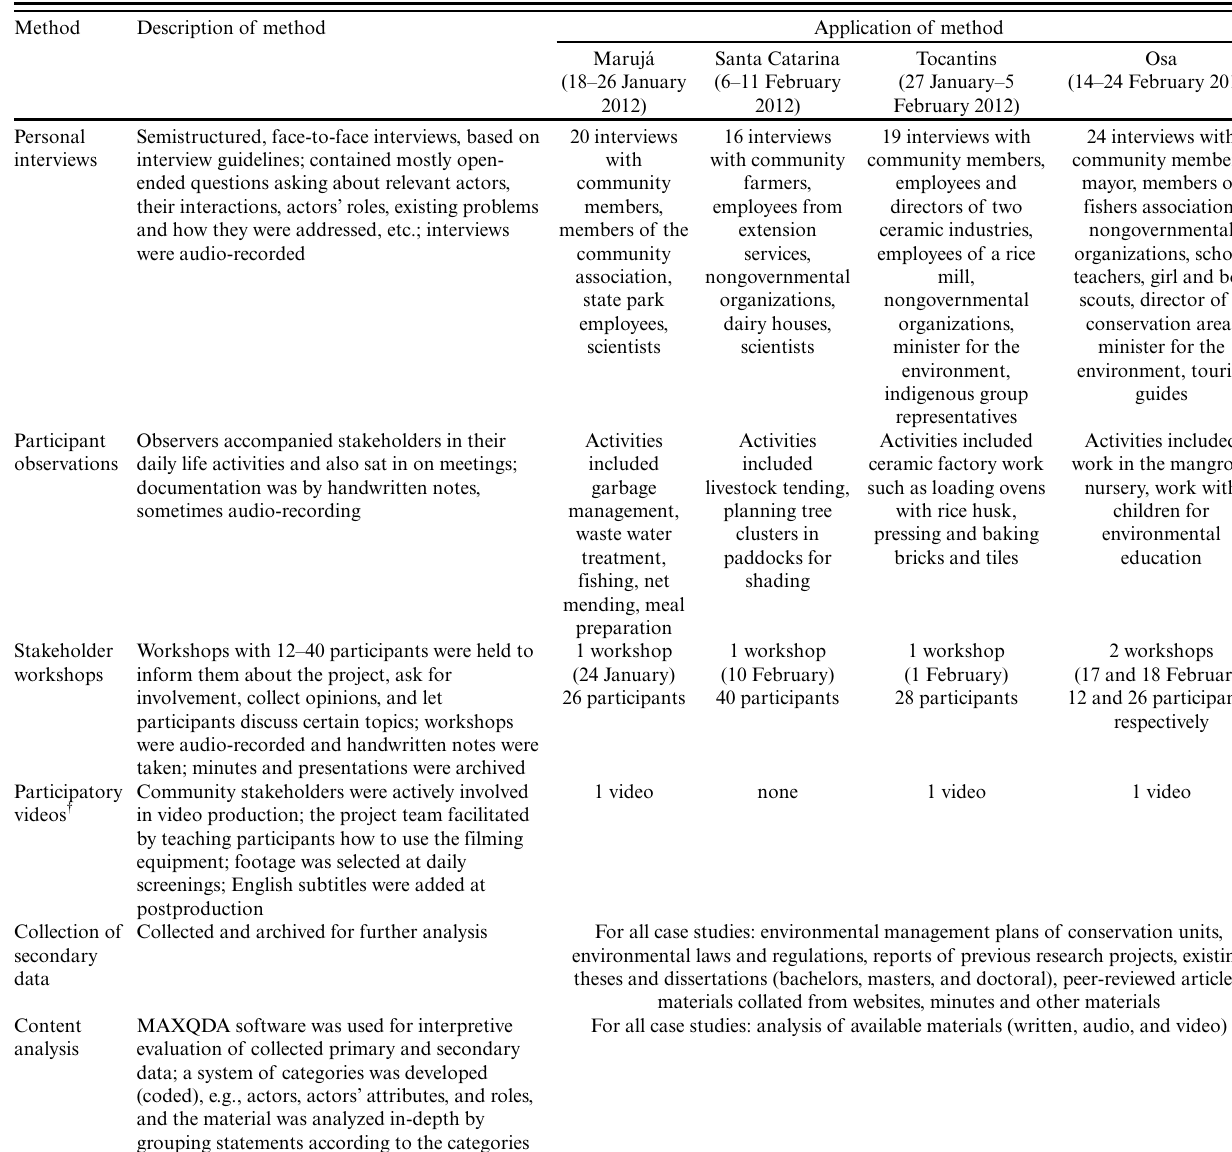
Table 2. Research methods used and their application in each case